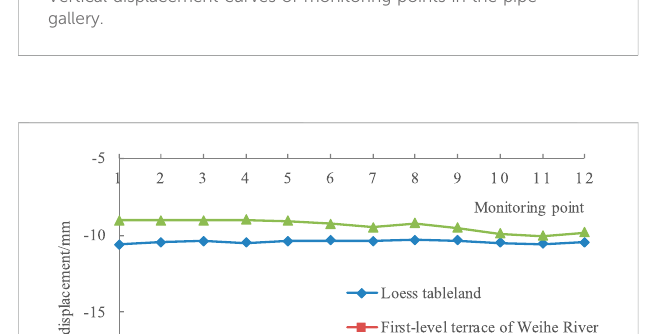
FIGURE 14 Vertical displacement curves under a 24 m tunnel buried